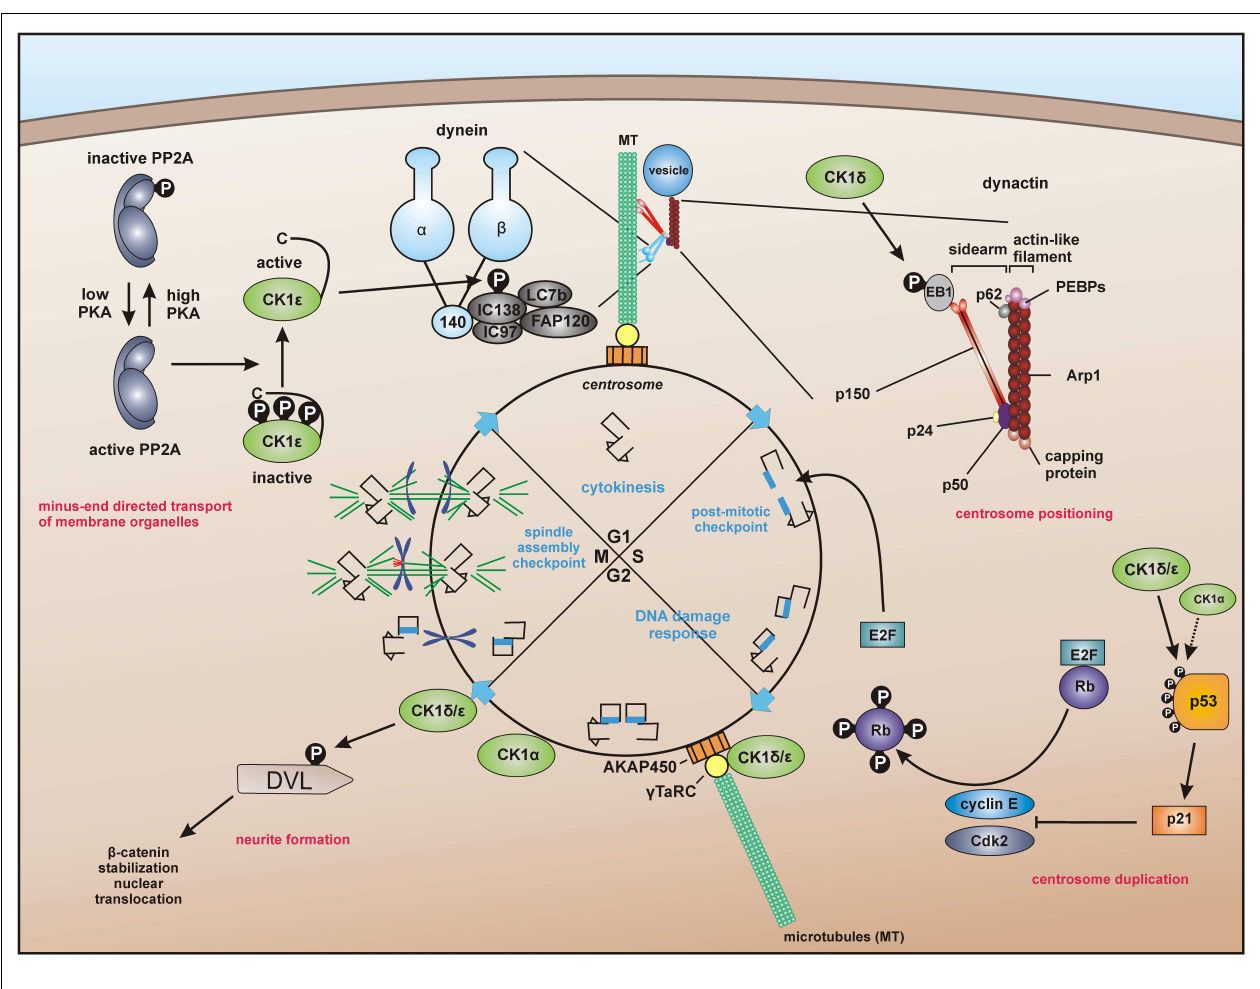
isoforms are related toWnt-signaling and neurite outgrowth by phosphorylation of DVL (229, 230). In addition, CK1 δ phosphorylates the end binding protein 1 (EB1), which is relevant for centrosome positioning duringT-cell activation (74). Furthermore, a subpopulation of p53 in coordinated function with CK1 at the centrosome could ensure the integrity of the centrosome and thereby maintain genomic stability